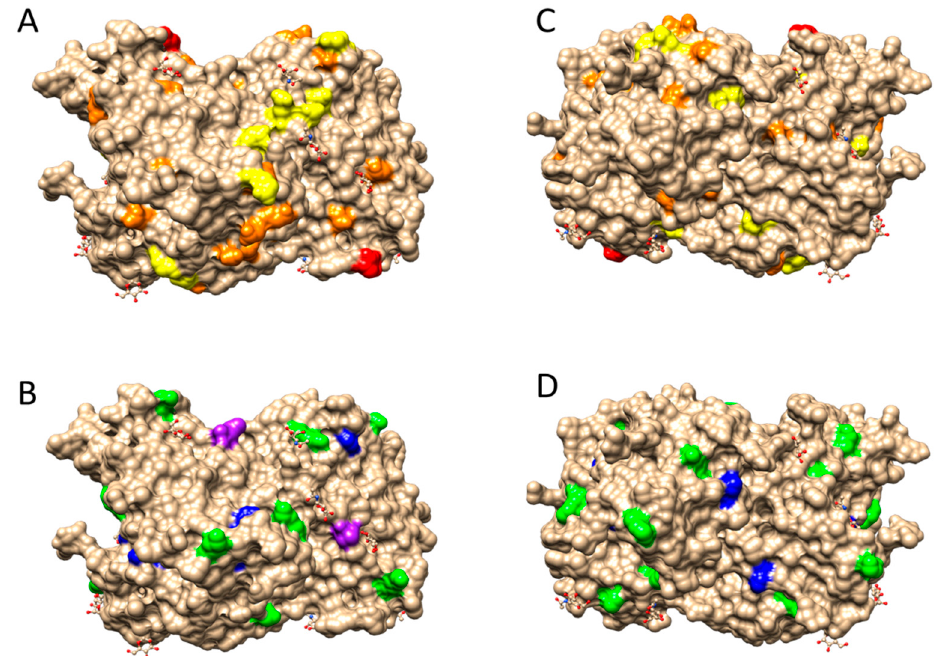
Figure 1. Structure of r Aae UPO. The figure shows a surface diagram of r Aae UPO showing some amino acids (green: lysine; blue: histidine; orange: aspartic acid; yellow: glutamic acid; red: C-terminal residue; purple: N-terminal residue) and the polysaccharide chains (balls and sticks) of side 1 ( A , B ) and the opposite side ( C , D ) of the enzyme. Sides were chosen by random.